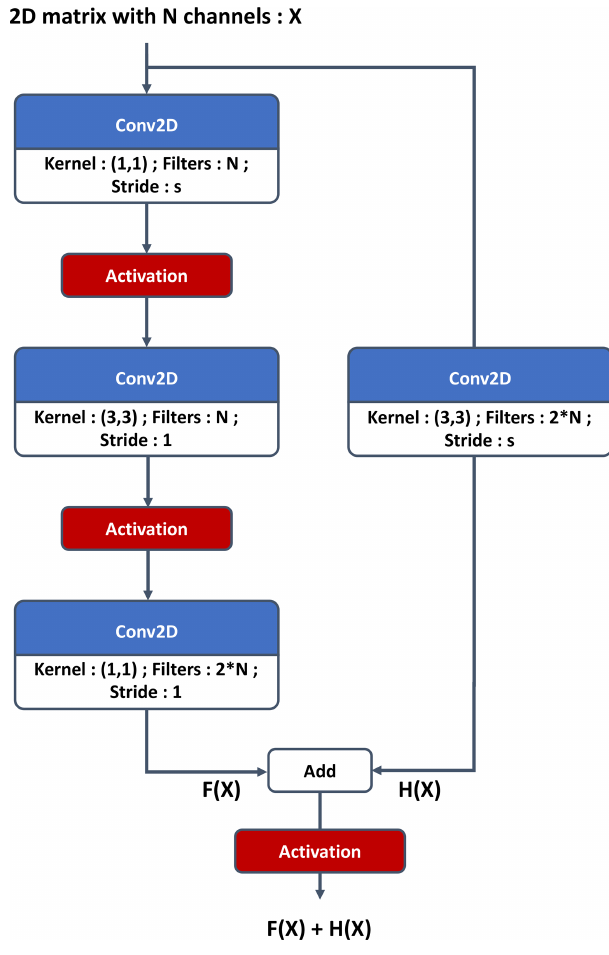
Figure 3. Residual convolutional block for the critic. If s is different from 1, it is referenced as a strided convolutional block in Fig. 1.